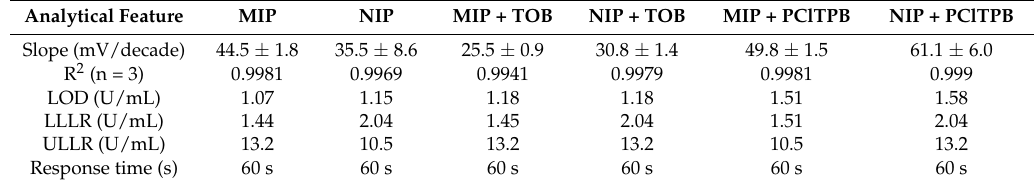
Table 2. Main analytical performance of the ISEs evaluated in 1.0 × 10 − 3 mol/L HEPES, pH 6.5. Analytical Feature MIP NIP MIP + TOB NIP + TOB MIP + PClTPB NIP +